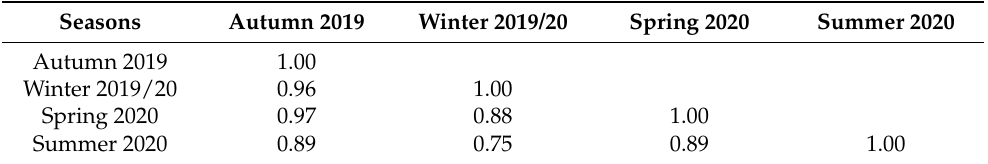
Table 5. The correlation coefficients of Pearson between the seasons of the year in the PM 2.5 samples from historical Jeddah